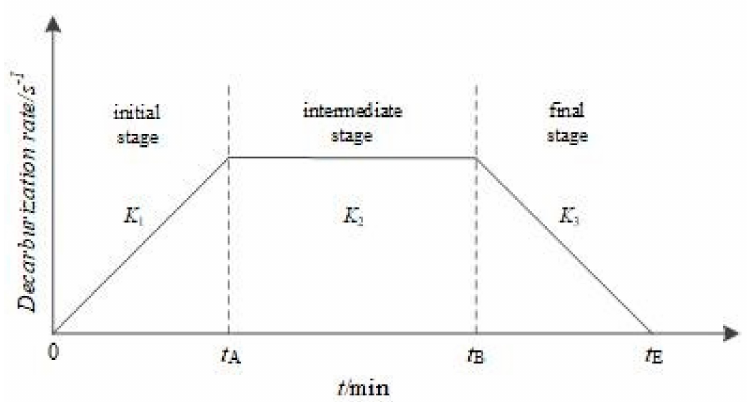
Figure 2. Variation in the decarburisation rate during the blowing process of converter steelmaking.